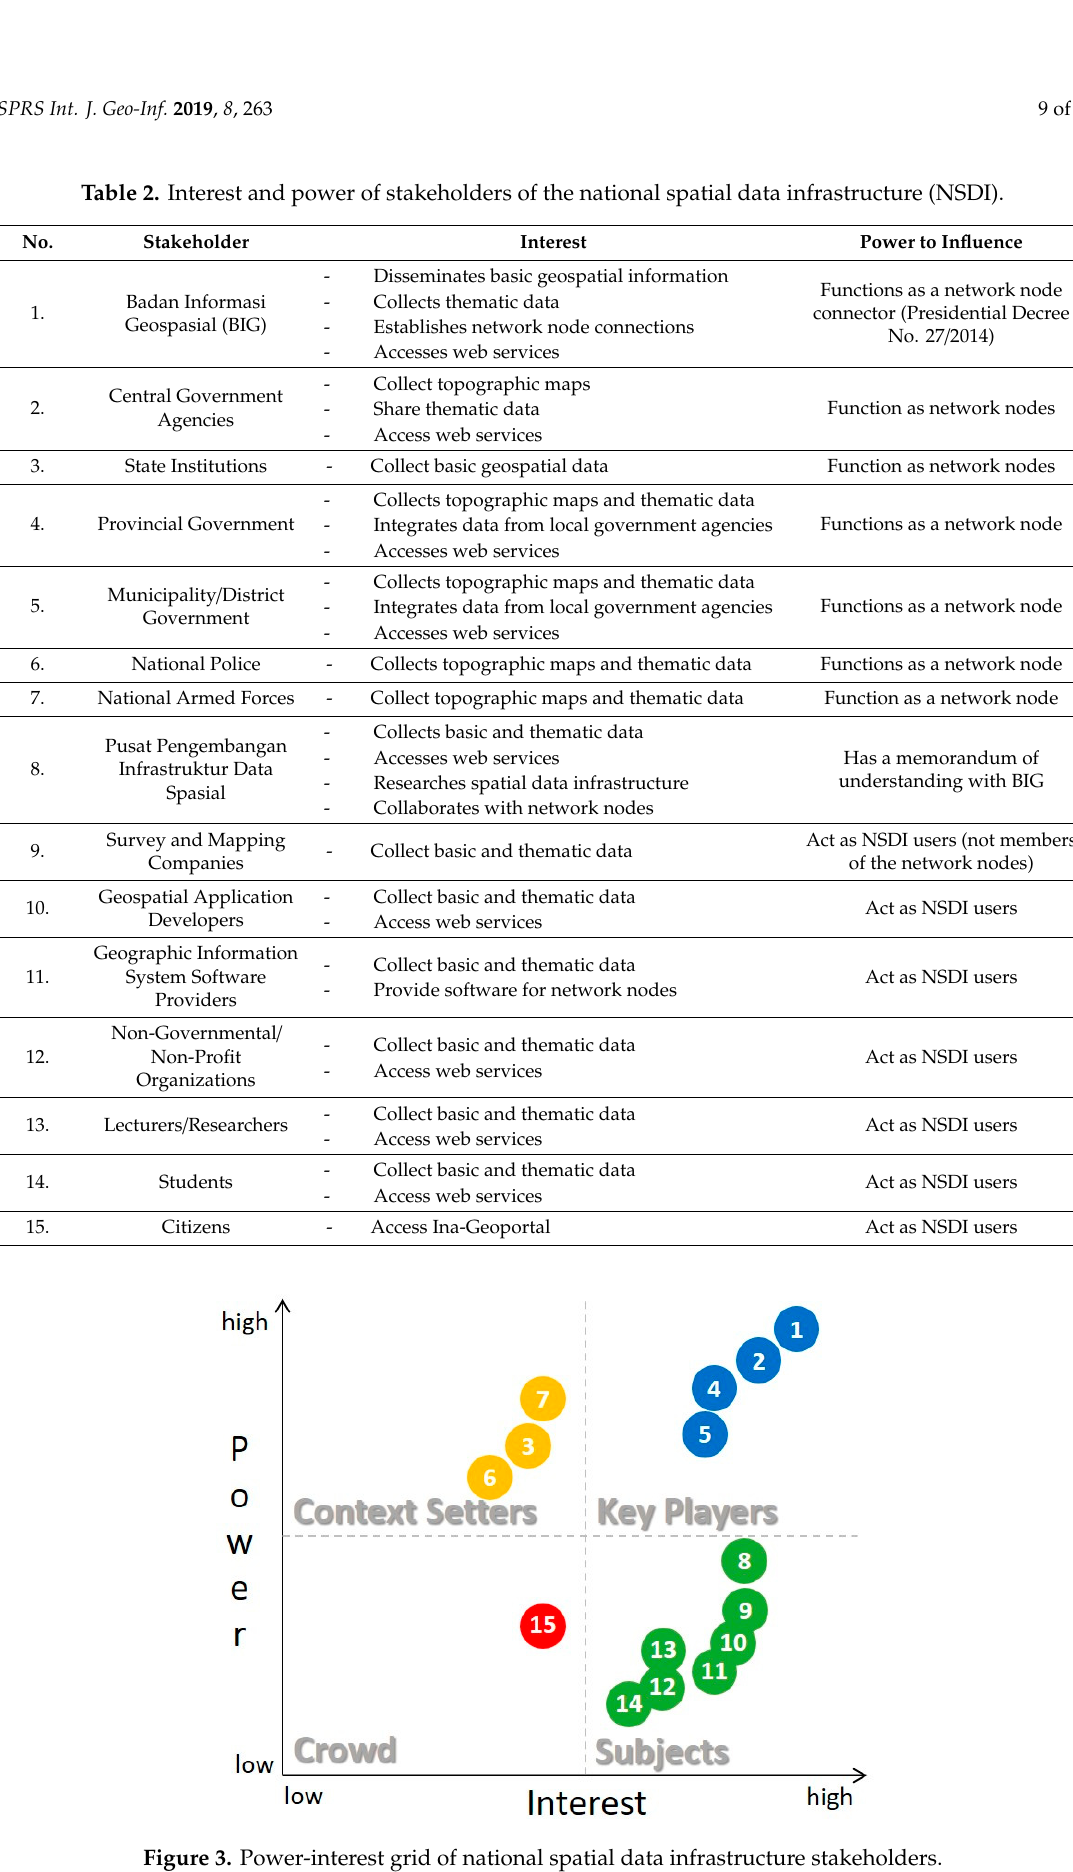
Figure 3. Power-interest grid of national spatial data infrastructure stakeholders.